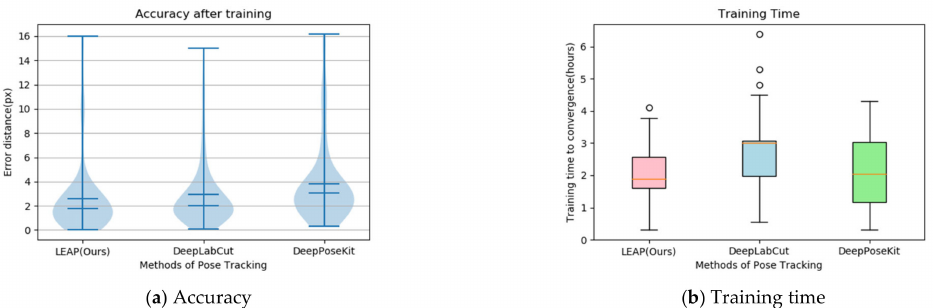
Figure 12. Accuracy and training time for the three models tracking joint points: ( a ) violin plots denote the overall error distribution, and the error bars denote the 25th and 75th percentiles; ( b ) the red, blue, and green boxes plot the training times of LEAP (Leap Estimate Animal Pose), DeepLabCut, and DeepPoseKit, respectively.